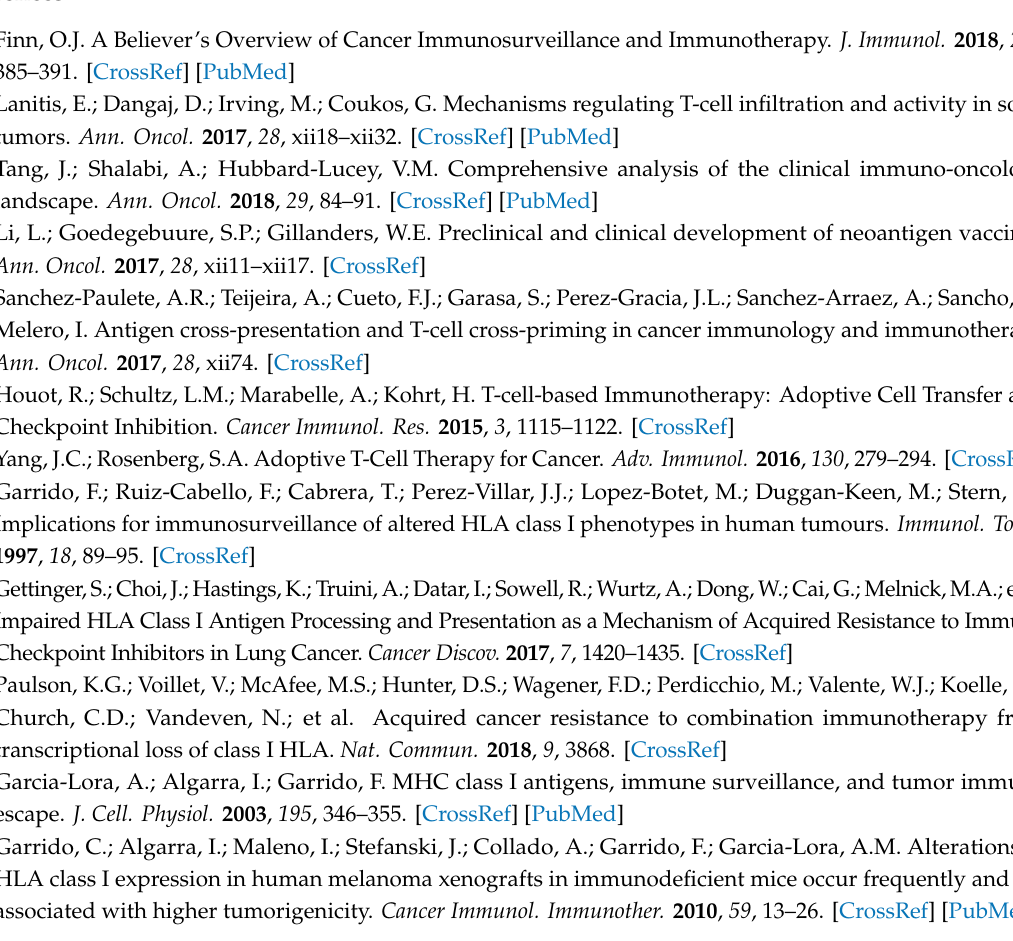
Figure S1. MHC-I phenotypes of B9 and B11 tumor cell lines under baseline conditions and after treatment with IFN- γ , Figure S2: MHC-I phenotypes of B9 and TB9-Fhit tumor cell lines under baseline conditions, Figure S3: MHC-I phenotypes of TB11-Fhit tumor cell line under baseline conditions and after treatment with IFN- γ , Figure S4: Nonclassical MHC-I and MHC-II phenotypes of B9 and TB9-Fhit tumor cell lines under baseline conditions, Figure S5: Apoptosis and necrosis data in B9 and TB9-Fhit tumor cell lines, Figure S6: In vitro susceptibility of Fhit-transfected versus non-transfected tumor cells to chemotherapeutic agents, TGF- β , TNF- α and IFN- γ , Figure S7: In vivo tumor growth of B11, B9 cells, TB11-Fhit and TB9-Fhit tumor cells in immunocompetent mice, nude mice and immunodepleted mice, Figure S8: Spectral karyotyping showing X and Y chromosomes in the B9 and B11 tumor cell lines, Table S1: Changes in activation markers in T lymphocyte subpopulations, Table S2: Primers for Real-time